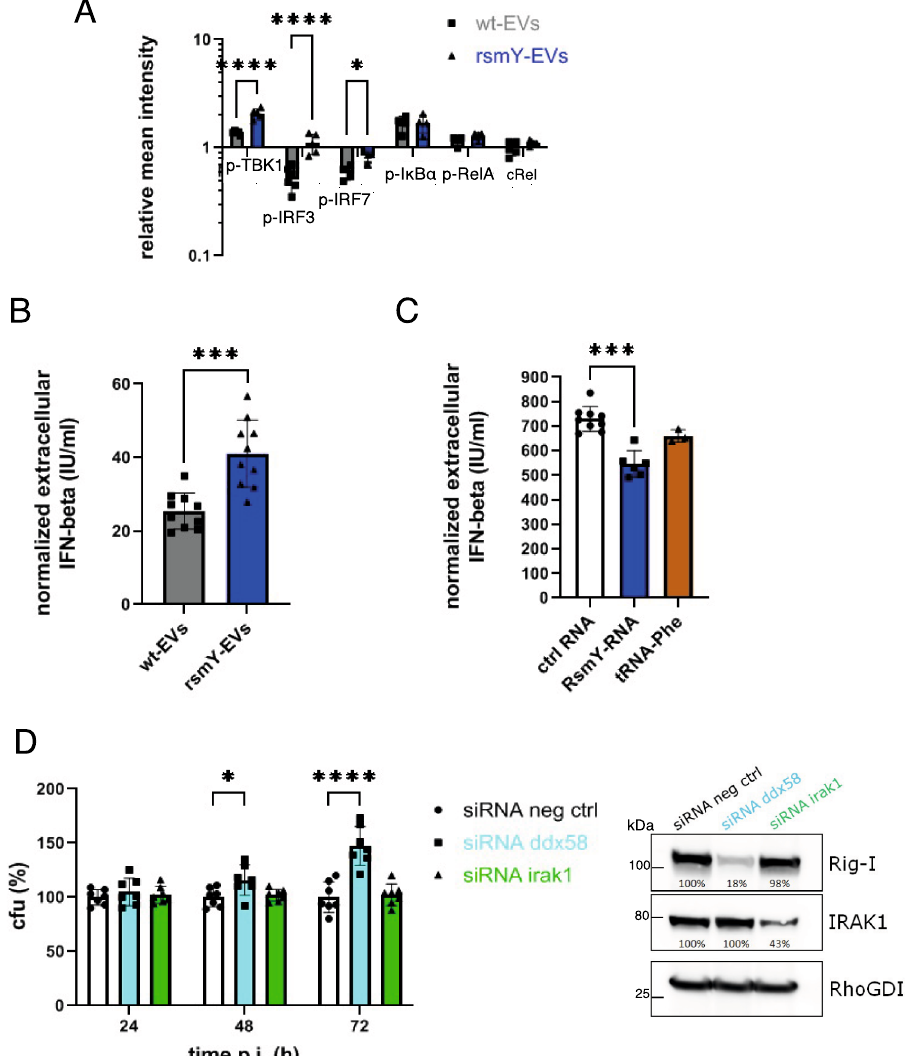
Fig. 5 RsmY transfection impacts RIG-I expression or when contained in Lp -EVs and decreases IFN-ß. A Quantitative analyses of the protein and phosphorylation levels of key proteins of the RLR and TLR signalling pathway analyzed after 3 h of-incubation of THP-1 cells with wt or the Δ rsmY Lp -EVs. wt (grey), Δ rsmY (blue). Mean intensities of the proteins, normalized against the value of non-infected cells and the RhoGDI loading control. Bars show the (mean) SD of n = 4 independent experiments. For statistical analysis, a two-way ANOVA with values of p < 0.05 signi fi cant (*), p < 0.01 (**), p < 0.001 (***) and p < 0.0001 (****) was performed. Source data provided as Source data fi le. B Extracellular IFN- β concentration of THP-1 cells incubated for 3 h with wt or Δ rsmY Lp -EVs. The bars indicate the (mean) SD of n = 10 independent experiments using an unpaired t-test for statistical analysis with two- tailed values of of p < 0.05 signi fi cant ( p = 0.0002). C THP-1 cells were transfected with in vitro transcribed RsmY, tRNA-Phe RNA, or non-speci fi c control RNA (ctrlRNA). The value for the ctrlRNA comprises the results of two control RNAs, a random short L. pneumophila DNA and the anti-sense sequences of RsmY (as-RsmY). Bars show the (mean) SD of n = 3 independent experiments using an unpaired t-test for statistical analysis (two-tailed), p < 0.05 signi fi cant ( p = 0.0007). In B and C the IFN-ß concentration of the supernatant was quanti fi ed and normalized against the values of the corresponding non-infected/non-transfected experiments. D THP-1 cells were transfected with siRNA targeting Rig-I ( ddx58 ), IRAK1 ( irak1 ), or a scramble control (neg ctrl). The protein expressions of RIG-I and IRAK1 were analyzed at time point T0, before infection with L. pneumophila . The graph shows the percentage of colony forming units (% cfu) at 24, 48, and 72 h post-infection relative to the scramble siRNA (neg ctrl). Bars show the (mean) SD of at least n = 7 independent experiments. For statistical analysis, a two-way ANOVA with values of p < 0.05 signi fi cant (*), p < 0.01 very signi fi cant (**), p < 0.001 extremely signi fi cant (***) and p < 0.0001 (****) was performed. Source data provided as Source data fi EVs puri fi ed either from wt L. pneumophila or from the Δ rsmY mutant strain. Indeed, as shown in Fig. 5B, internalization of Lp - to a lesser extent of tRNA-Phe lead to a signi fi cant lower IFN- β EV containing RsmY (puri fi ed from the wt strain) induces less IFN-ß secretion by the host cells, than those infected with Lp -EVs from which RsmY is absent (puri fi ed from the Δ rsmY strain). These results suggest that Lp -EVs containing RsmY dampen IFN- β secretion of infected human cells. To further substantiate this fi nding, we transfected THP-1 cells with RNA to activate RIG-I- puri fi ed from the RsmY mutant strain at 3 h pi. Our results